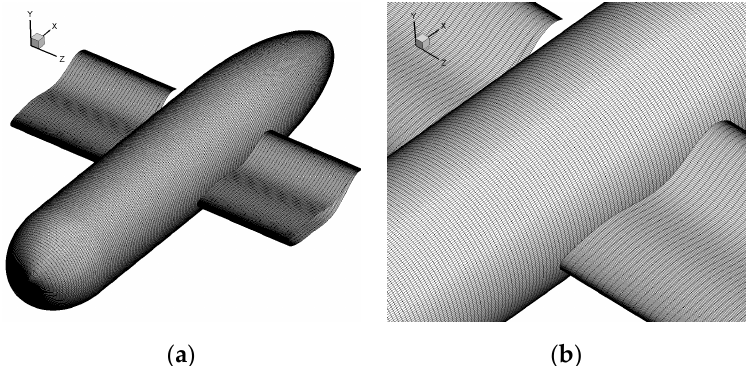
Figure 2. Distribution on the surfaces of the AUG. ( a ) Grid distribution on the whole surfaces; and ( b ) close view of the surface.